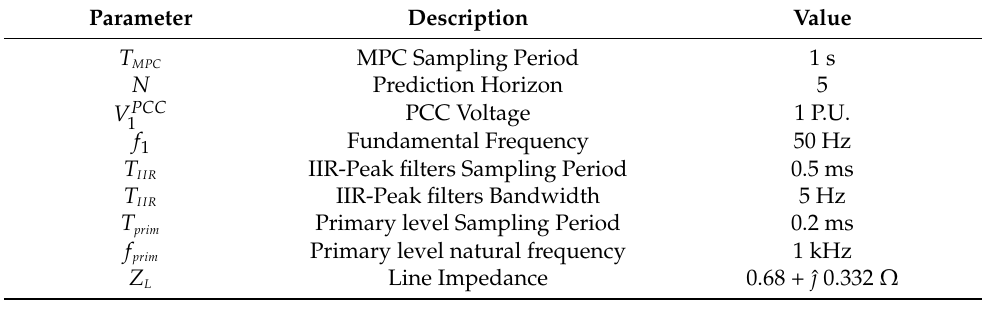
Table 1. General Parameters.